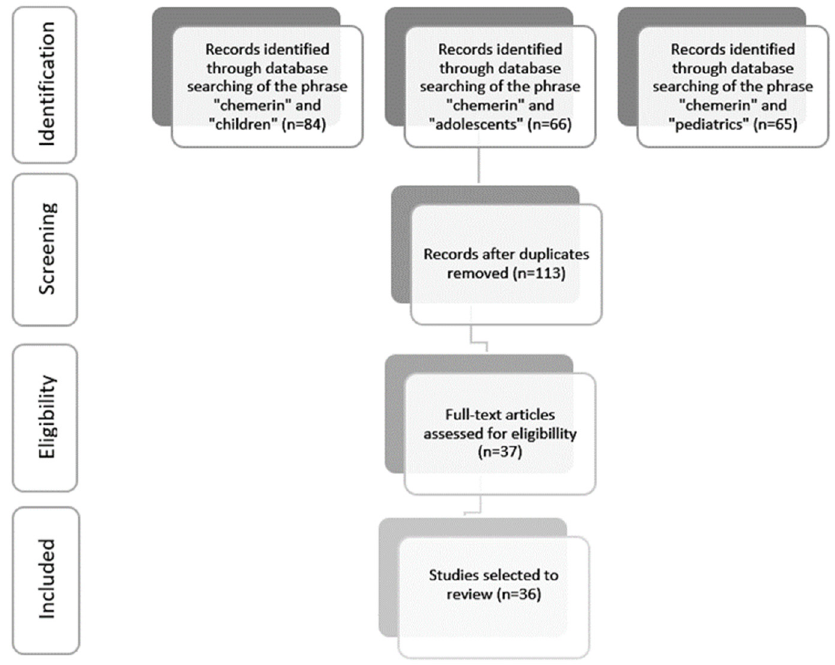
Figure 3. Flow of information through the different phases of the systematic review.